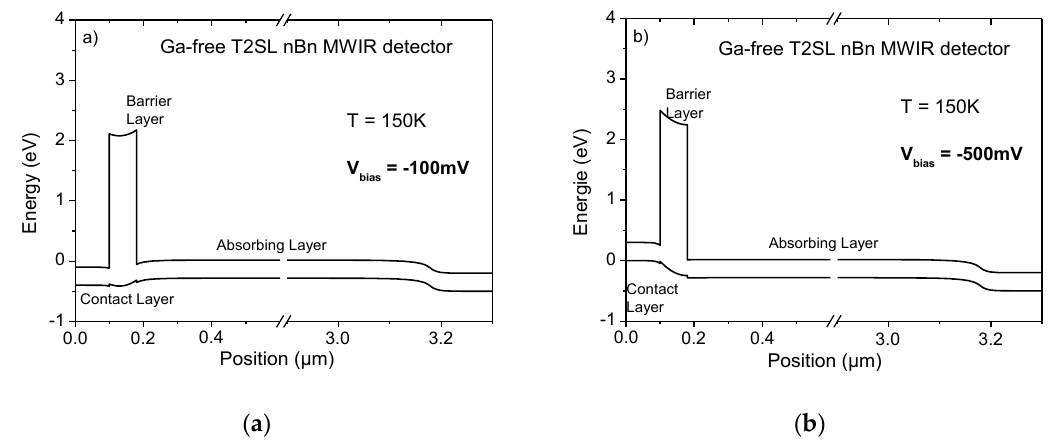
Figure 12. Calculated band diagrams of the Ga-free T2SL nBn barrier structure at 150 K and ( a ) − 100 mV, ( b ) − 500 mV.